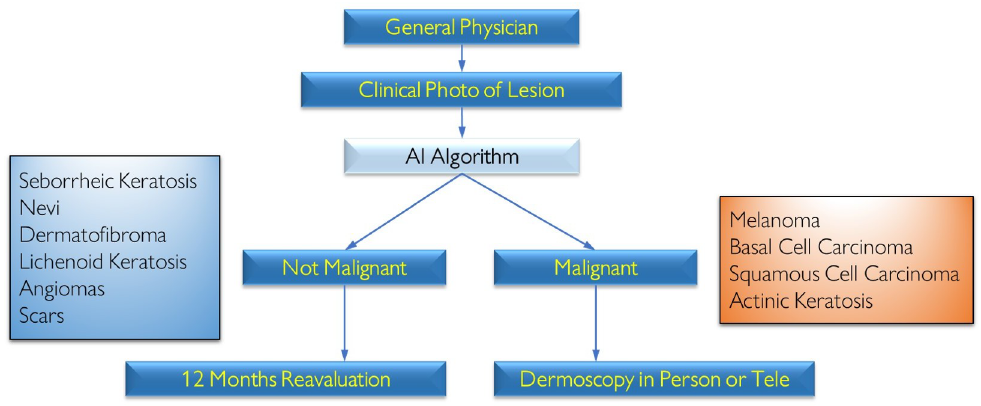
Fig 1. Patient flow for clinical images taken by primary care physicians and possible outcomes and suggested management. If the lesion was suspected to be benign, the management suggested it is to reassess the lesion in 12 months. If the lesion was suspected to be malignant, the management would depend if the PCP had access to the dermoscopy image. If yes, the image would be sent to a dermatologist (Teledermoscopy). If not, the PCP would have to send the patient for in- person